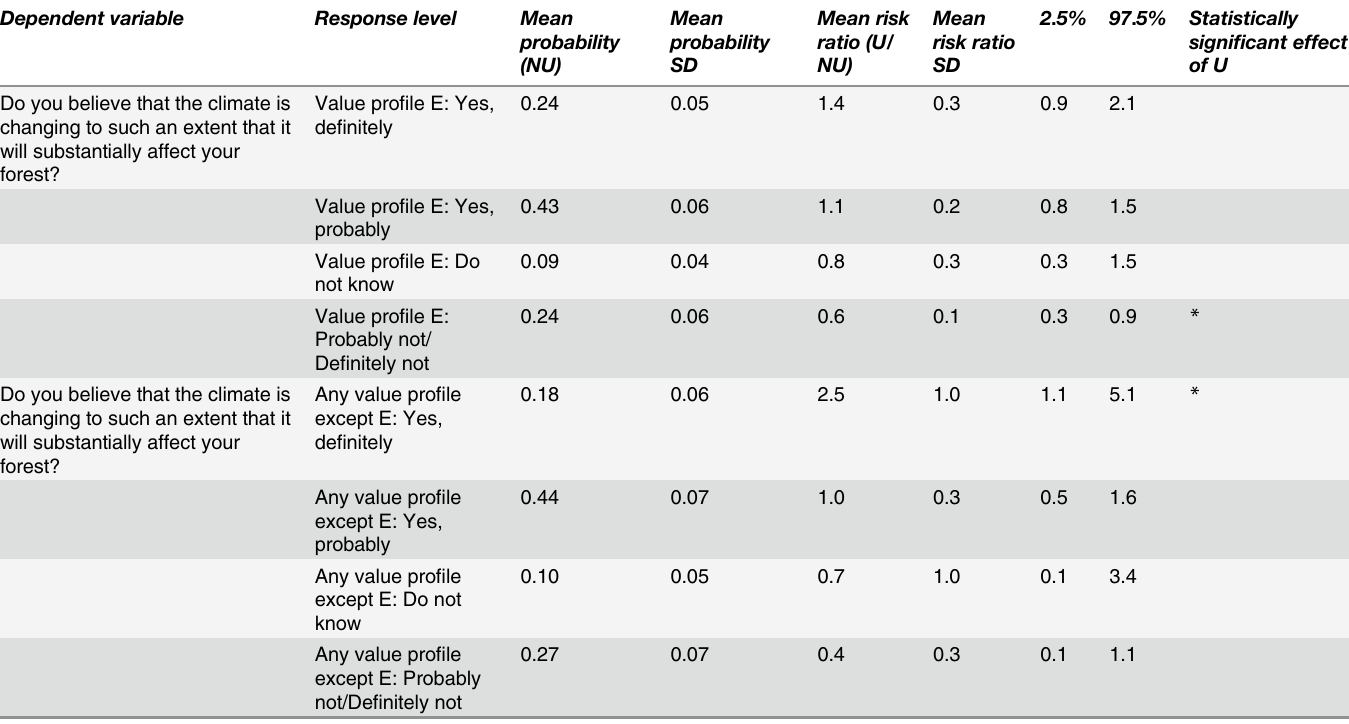
Table 3. Predicted probabilities for strengths of belief in the local effects of climate change based on no university education and value profile, and relative risk ratios for strengths of belief in the local effects of climate change based on the education level (have/have not university educa- tion) and value profile using the model for Swedish respondents (S5